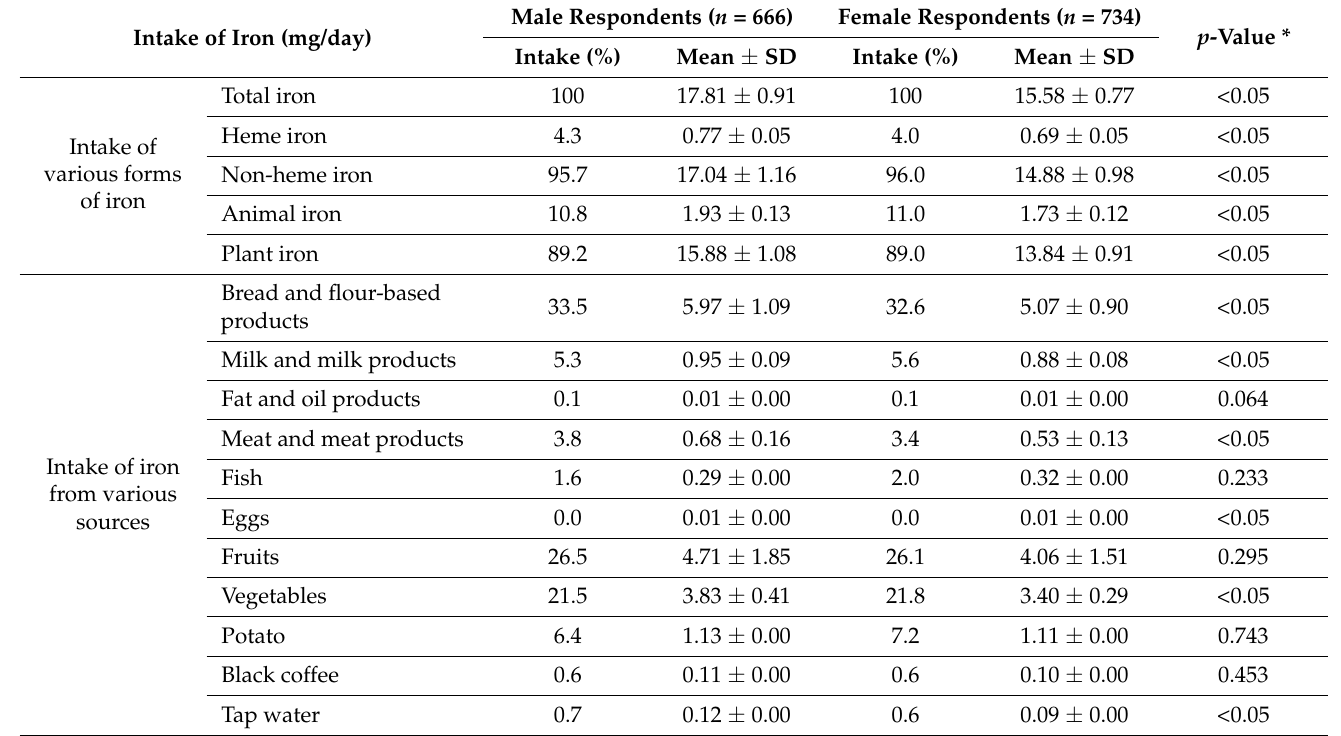
Table 2. Comparison of intake of various forms of iron along with that of iron intake from various sources in the national sample of Armenian adults among male and female